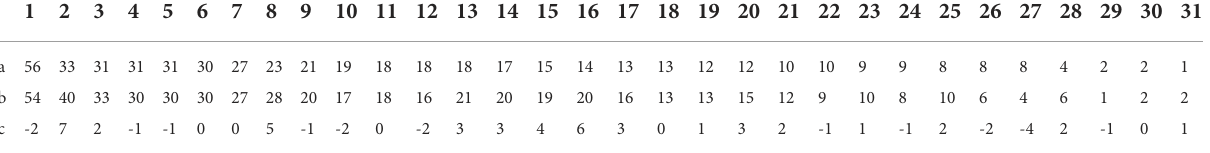
TABLE 1 Number of reproductive center gaps by provinces and cities in China in the second half of 2020 (unit: